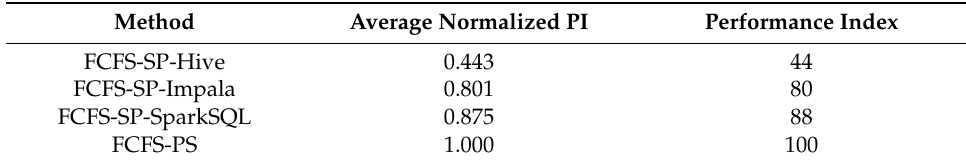
Table 11. Average normalized performance index for Case 1.